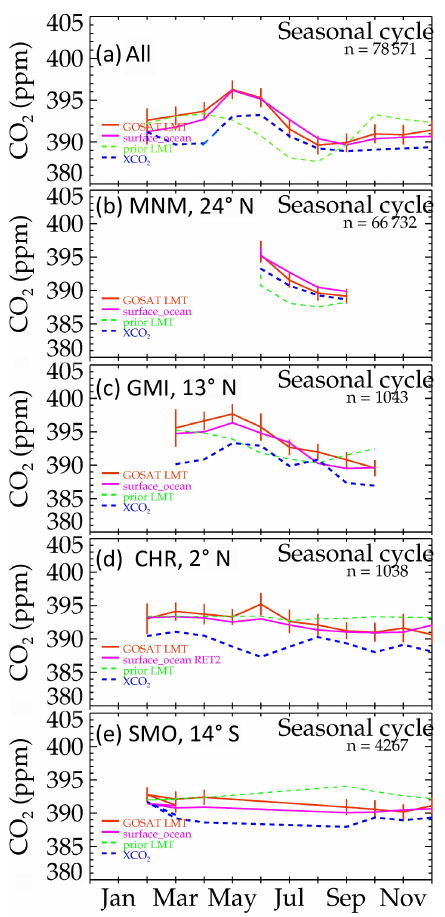
Figure 8. GOSAT LMT compared with remote ocean surface sites. GOSAT (red) improves over the prior (green dashed) versus surface sites (pink) for the average over all sites (a) and at the four sites with the most matches (b–e) . X CO 2 values are shown for comparison (blue